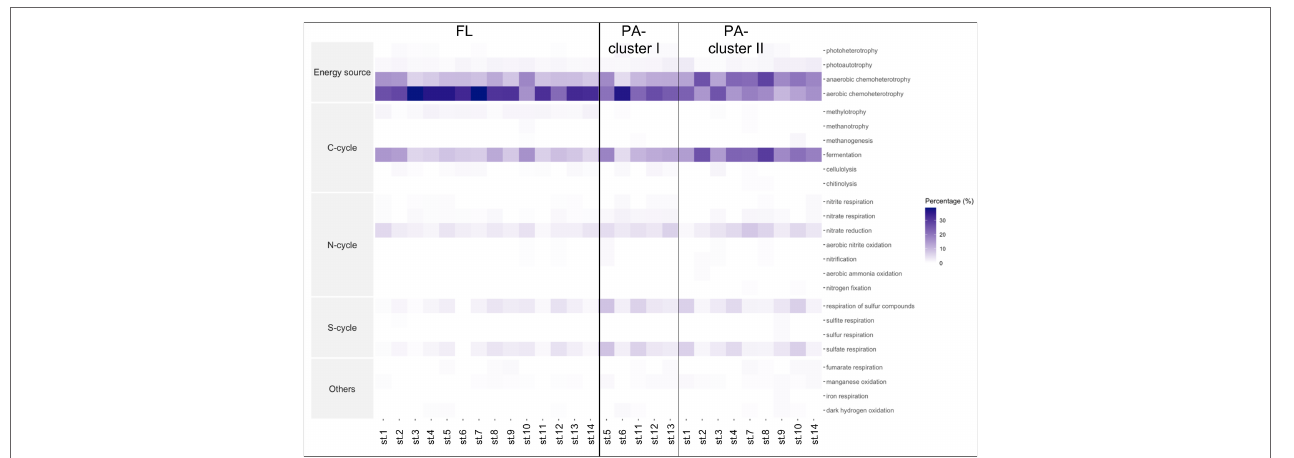
FIGURE 7 | Heatmap of the function distributions generated by FAPROTAX. The columns correspond to the samples and the rows correspond to the percentage of functional groups predicted within each sample. On the left, the Free-Living (FL) samples, and on the right, the Particle-Attached (PA) samples separated in the 2